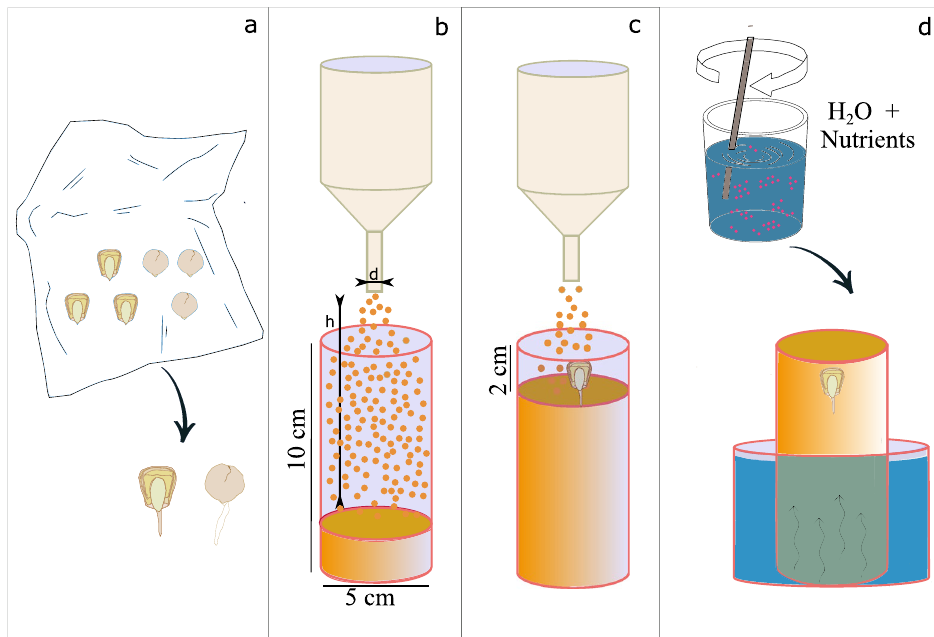
Figure 1. Main steps of the preparation of the root-soil specimens: ( a ) foil-wrapped seeds on germination filter paper, ( b ) sand deposition at controlled bulk density by air pluviation, ( c ) positioning of the germinated seed in the cell during sand pluviation, ( d ) watering of specimens using water enriched of